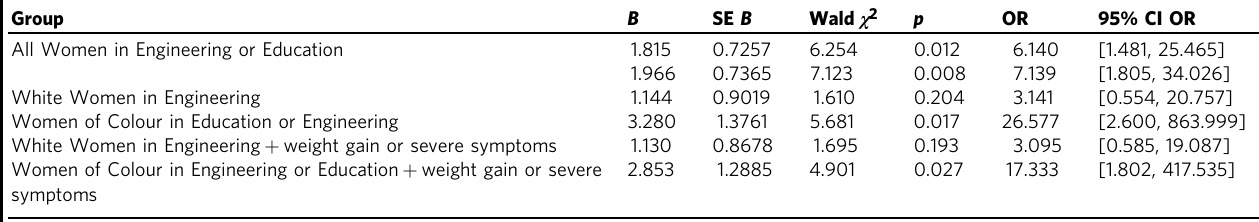
Table 1 Strati fi ed binary logistic regression results for women in Engineering or Education. Group